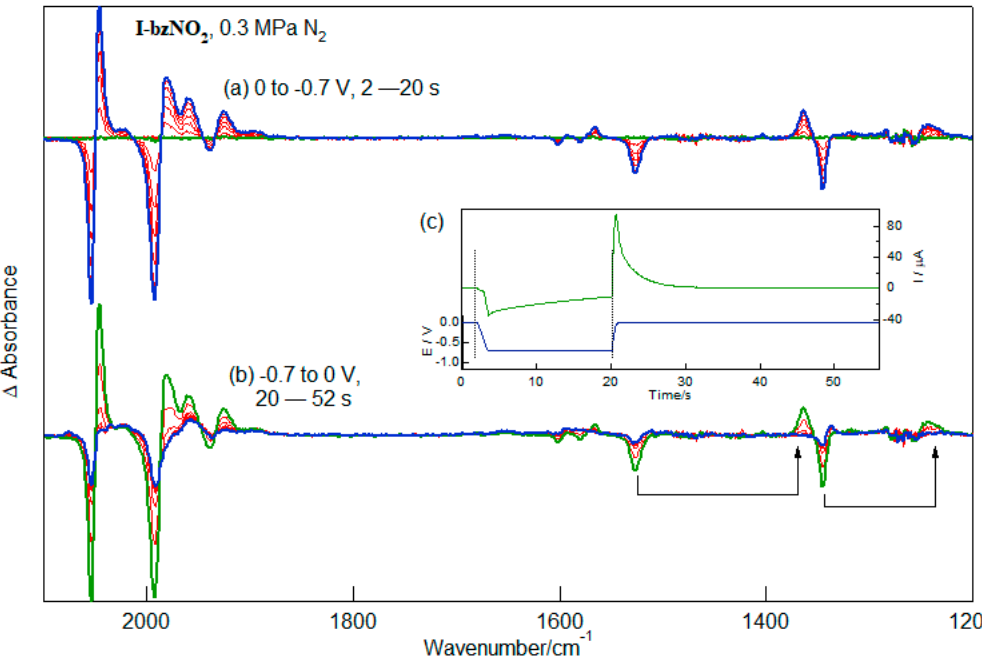
Figure 5. IR-SEC recorded during (a) reduction and (b) re-oxidation of I-bzNO 2 in CH 2 Cl 2 (2 mM,